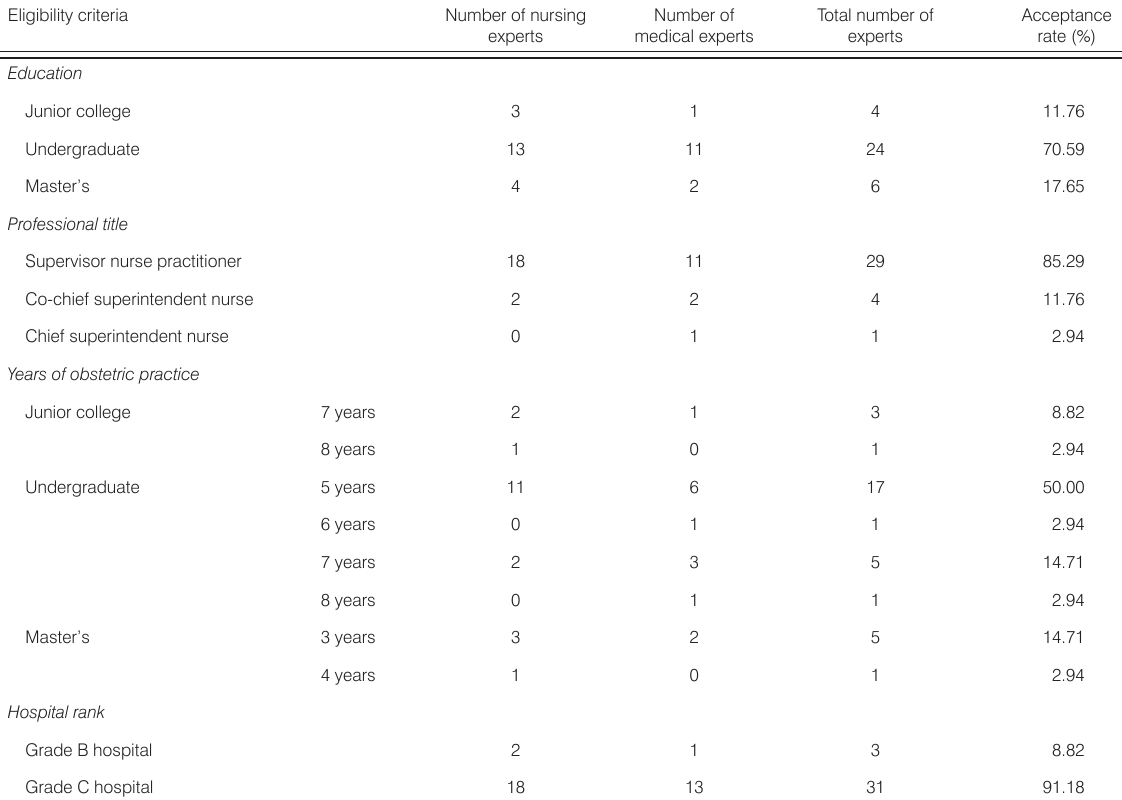
Table 7. The consensus on the minimum acceptable eligibility criteria for prescriptive authority for midwives ( n =